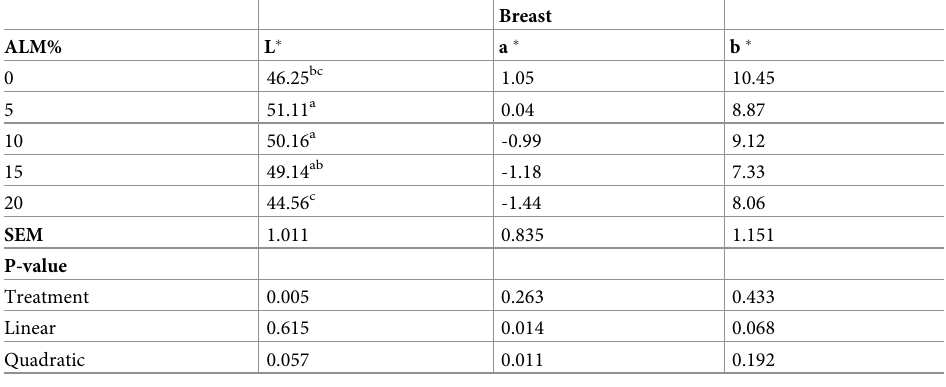
a, b, c Means in the same row not sharing a common superscript are different (p < 0.05). Diets: ALM0% = a diet having no amaranth leaf meal inclusion, ALM 5% = a diet having 5 g/kg of amaranth leaf meal inclusion, ALM10% = a diet having 10 g/kg of amaranth leaf meal inclusion. ALM15% = a diet having 15 g/kg of amaranth leaf meal inclusion. ALM20% = a diet having 20 g/kg of amaranth leaf meal inclusion. SEM: standard error of the